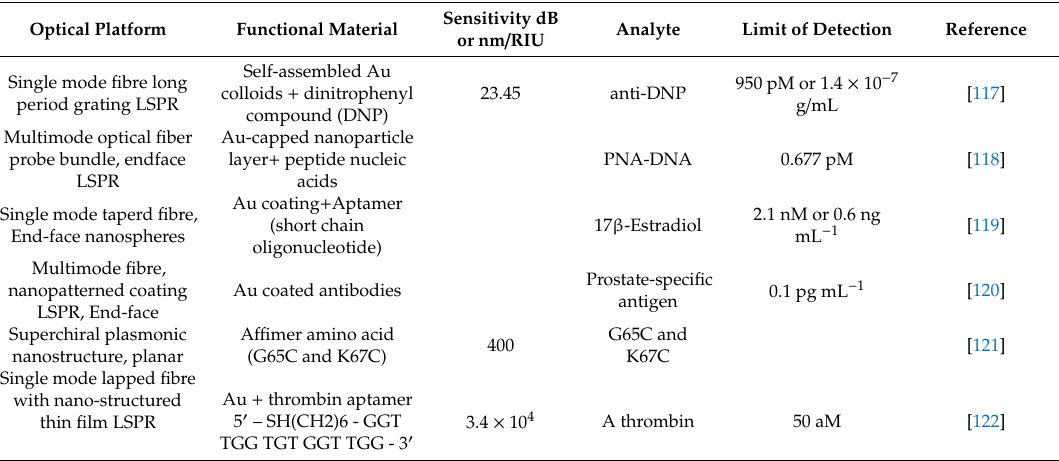
Table 7. Examples of various optical plasmonic